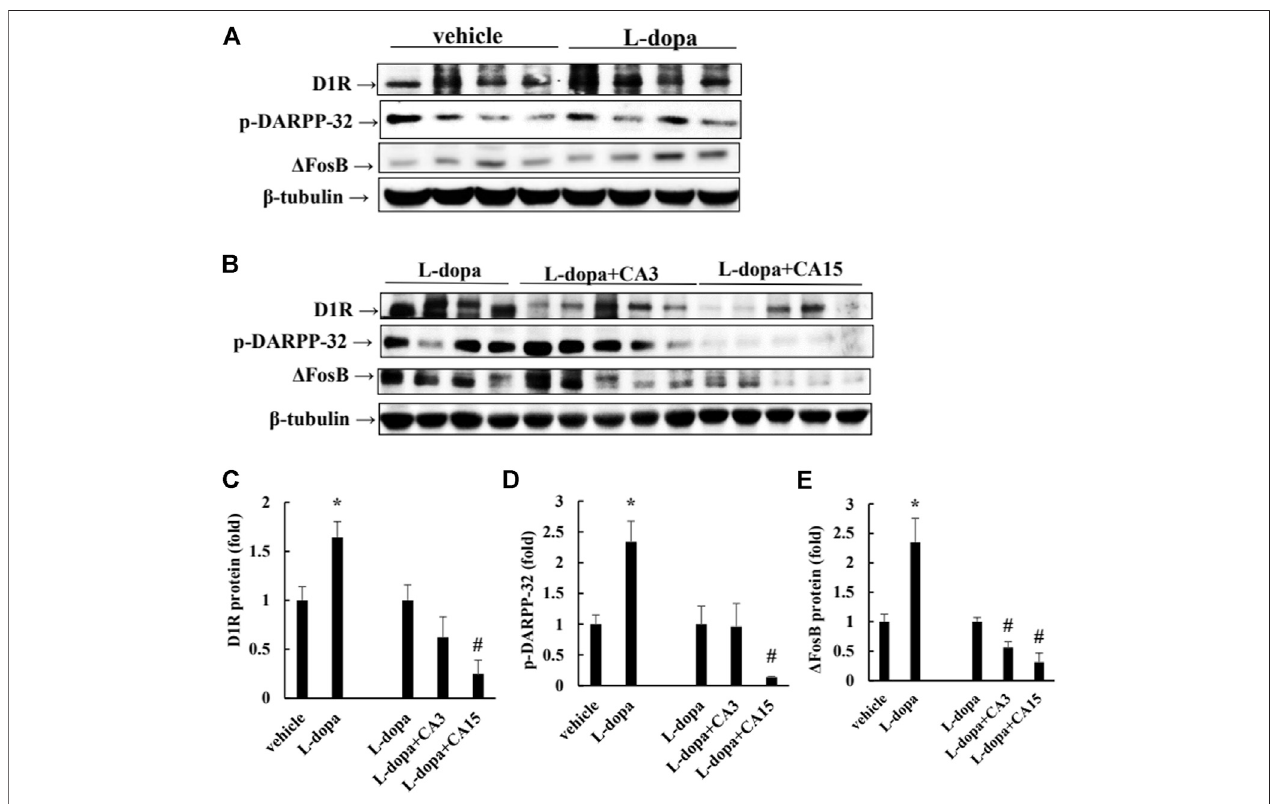
FIGURE 2 | Effect of CA on L -dopa-induced D1R, p-DARPP-32, and Δ FosB protein in 6-OHDA-lesioned rats. (A,B) D1R, p-DARPP-32, and Δ FosB protein were determinedbyWesternblotting. β -Tubulinwasusedastheinternalcontrol. (C – E) Thelevelofthe L -dopagroupwassetat1.0.Valuesaremean ± SEM( n (cid:1) 3).# p < 0.05 compared with L -dopa-treated